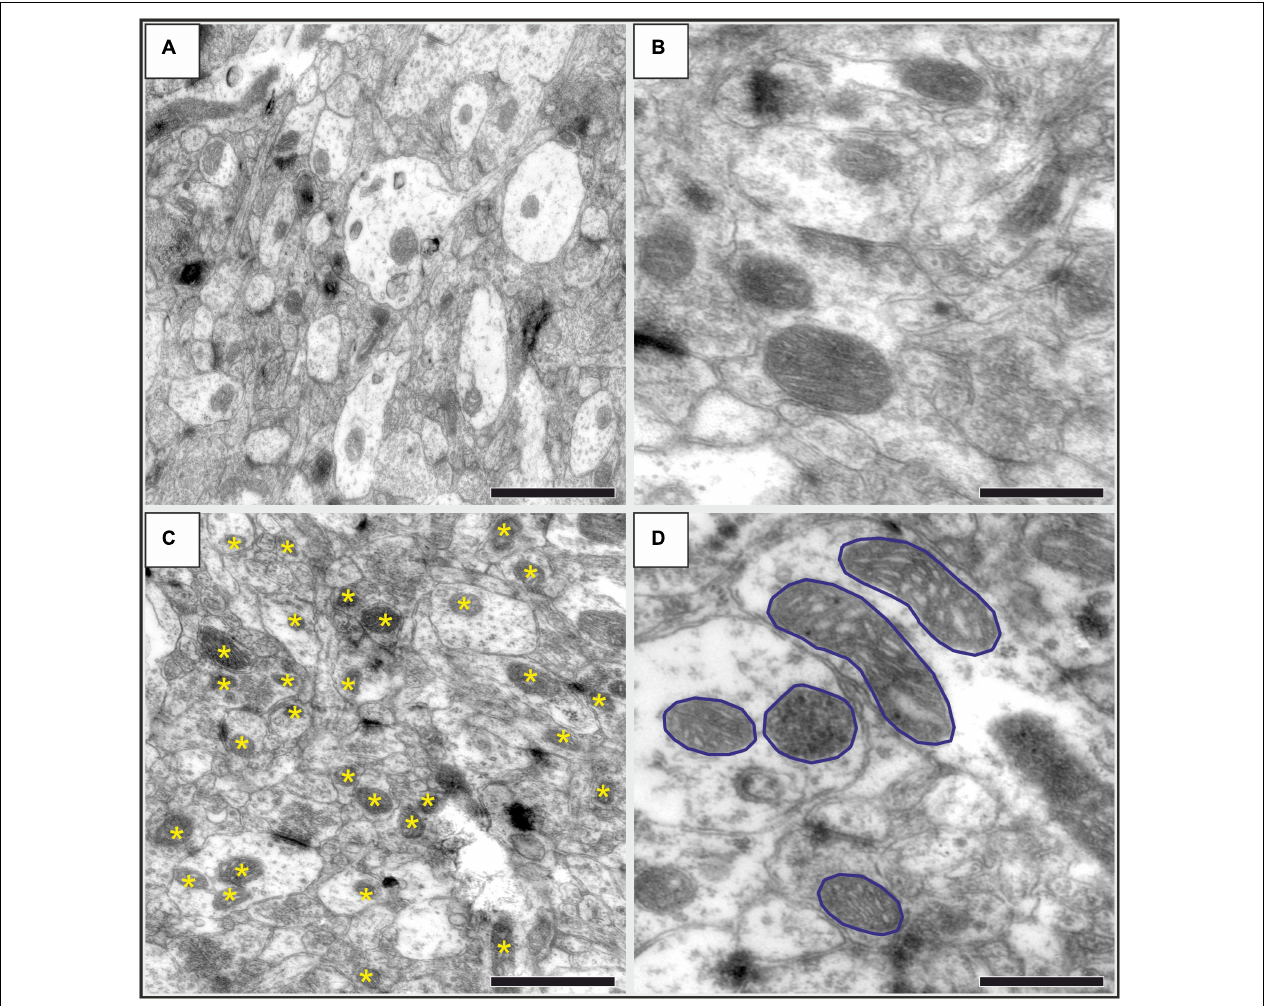
FIGURE 2 | Representative high-resolution electron microscopic images showing the neuropil in the infralimbic cortex in control (A,B) and stressed (C,D) rats. (A) An image with 30000 × magnification, where numerous mitochondria are visible both in dendritic (brighter areas) and in axonal (darker areas) structures. Scale bar: 1 µ m. (A) Representative images with mitochondria with higher magnification (40000 × ). The outer and inner mitochondrial membranes, matrix and cristae are clearly visible. Scale bar: 500 nm. (C) An image with 30 000 × magnification displaying the neuropil in a stressed rat. Asterisks identify the mitochondria as it was marked with the Neurolucida software when we counted them. Scale bar: 1 µ m. (D) An image with 40000 × magnification showing several mitochondria with their cross-sectional profiles outlined for the morphological analysis. Scale bar: 500